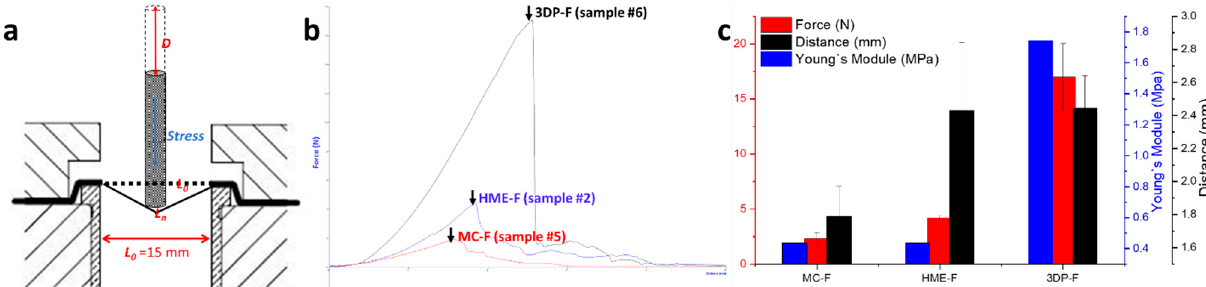
Figure 10. ( a ) Demonstration of the film burst test setups; ( b ) force-distance curve of the film burst test; ( c ) the breaking force, distance, and Young’s module of MC-F, HME-F, and 3DP-F.